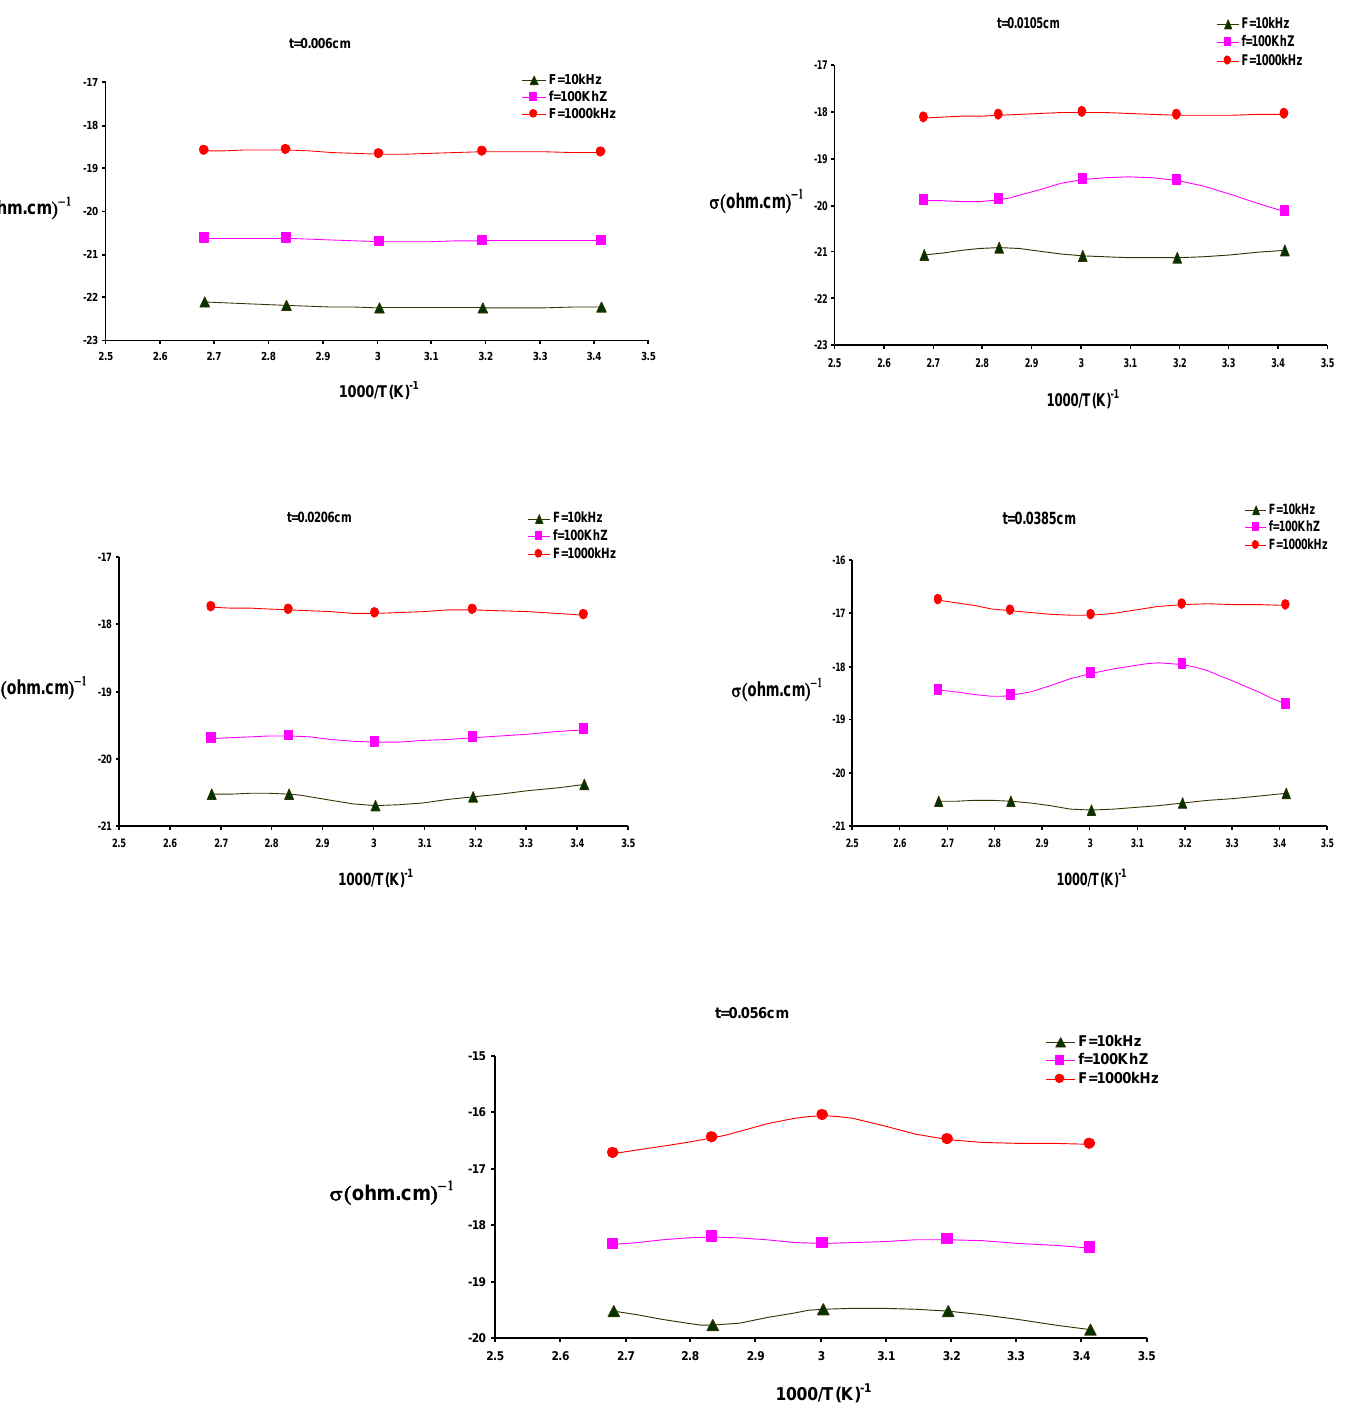
Fig.8: Temperature dependence of AC conductivity for PMMA film of different thickness at different